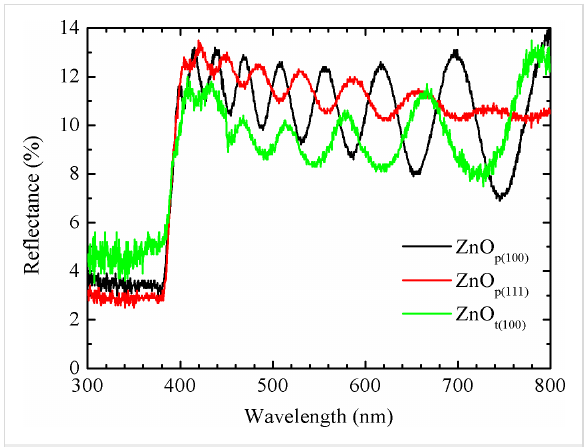
Figure 8: Reflectance spectra of the samples (a) ZnO p(100) , (b) ZnO p(111) , and (c) ZnO t(100) at room